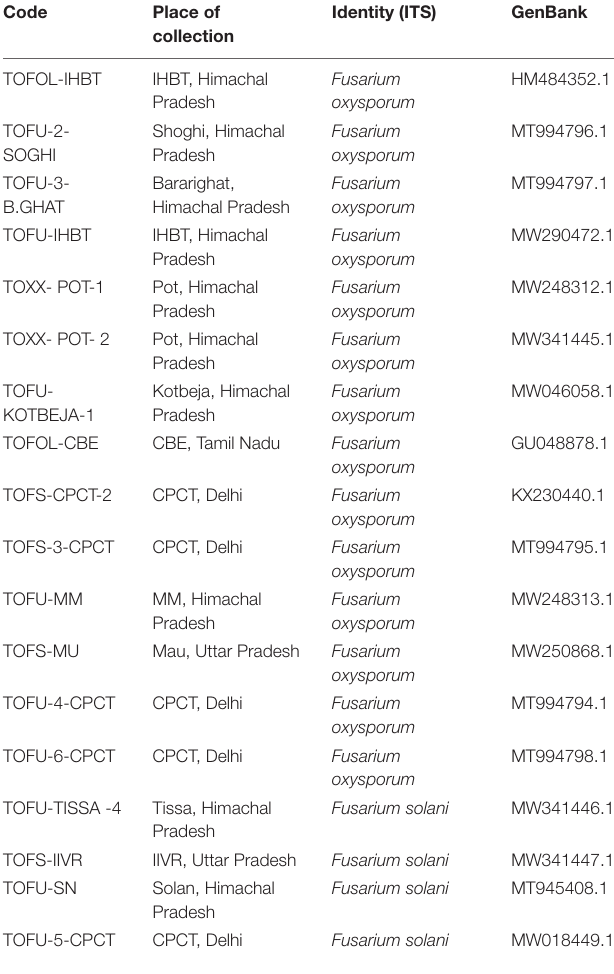
TABLE 2 | List of Fusarium isolates of tomato used to study the genetic